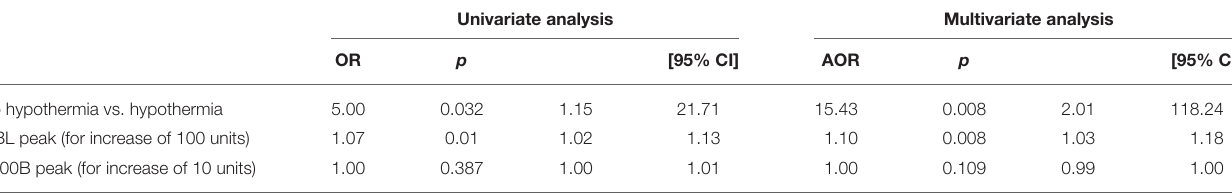
TABLE 4 | Crude and adjusted risk of worse MRI (Barkovich score 3/4) at 7–10 days of life or death.